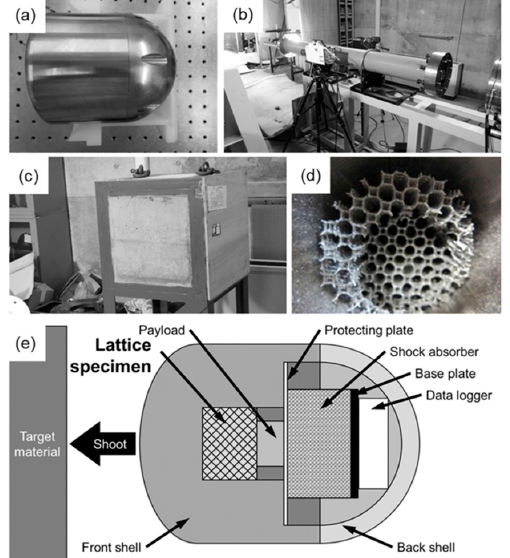
Figure 2. Schematic illustrations showing static indentation tests for lattice specimens.